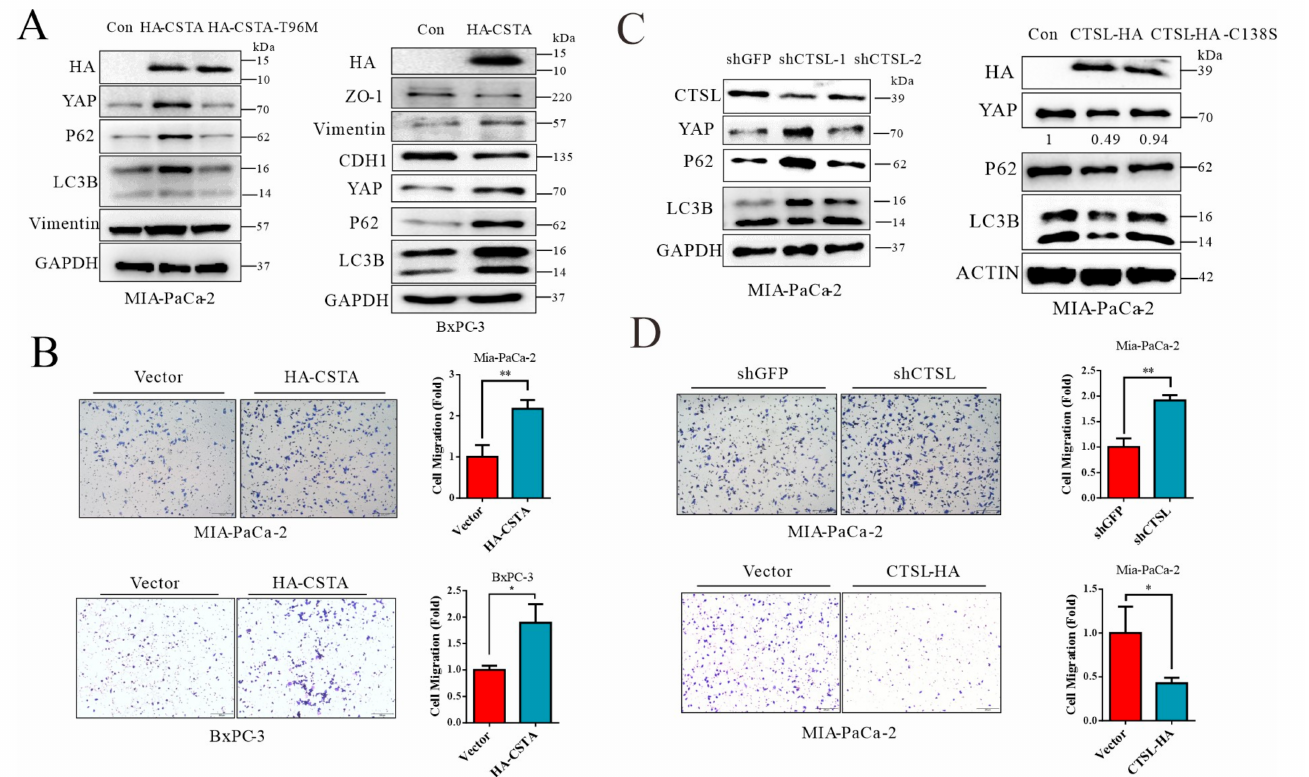
Figure 6. Forced expression of cystatin A leads to lysosomal stress and failed autolysosomal flux, leading to YAP accumulation in cancer cells. ( A ) Western blot analysis of BxPC-3 and MIA-PaCa-2 cells overexpressing CSTA. ( B ) Transwell analysis of MIA-PaCa-2 and BxPC-3 cells with vector or CSTA overexpression. Scale bars = 200 µ m. ( C ) Western blot analysis of MIA-PaCa-2 cells with shRNA-based knockdown of CTSL (top). Western blot analysis of MIA-PaCa-2 cells overexpressing CTSL or CTSL mutations (bottom). ( D ) Transwell analysis of MIA-PaCa-2 with shRNA-based knockdown of CTSL (top). Transwell analysis of MIA-PaCa-2 cells overexpressing CTSL (bottom). Scale bars = 200 µ m. * p < 0.05, ** p < 0.01. The original Western Blot figures can be found in the Supplementary File